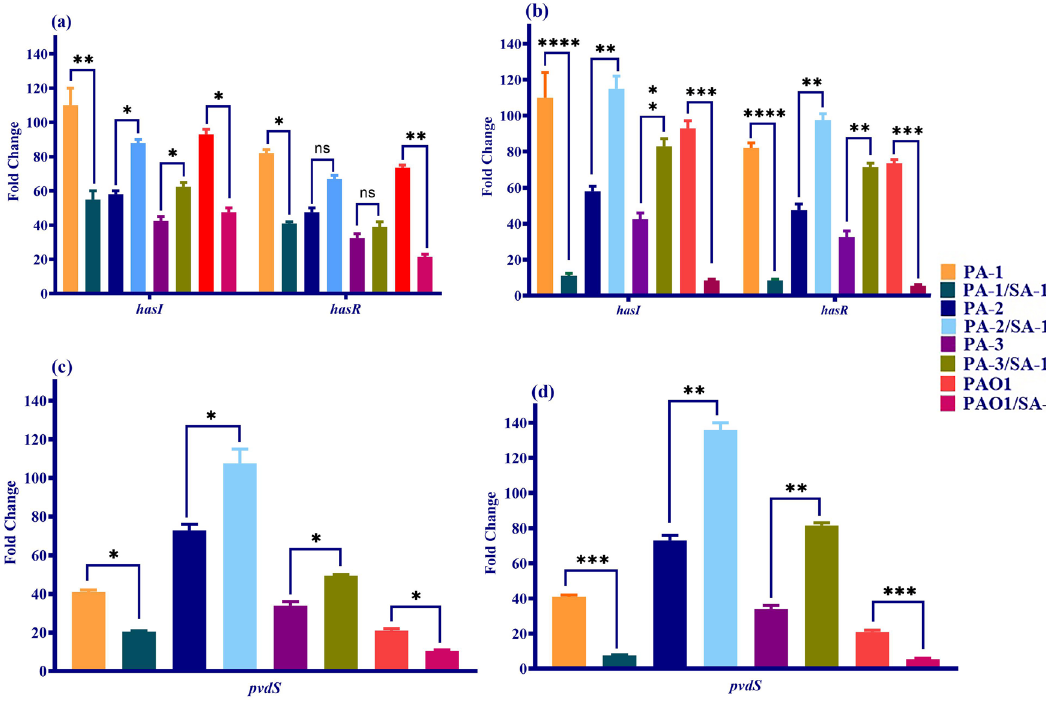
Figure 3. The expression level of ECF sigma factors of P. aeruginosa in different states of co-culture. ( a ) The expression level of hasI and hasR in the planktonic co-culture compared to the monoculture and control strain. ( b ) The expression level of hasI and hasR in the biofilm state of co-culture in comparison to the monoculture and control strain. ( c ) The pvdS changes in P. aeruginosa strains in the planktonic forms of the co- and monoculture. ( d ) The pvdS changes in P. aeruginosa strains in the biofilm forms of the co- and monoculture. Each data set was analyzed using the student’s t-test, and the Holm-Sidak method for multiple comparison. The data were presented as Mean + SEM. *p-value < 0.05; **p-value < 0.01; ***p-value < 0.001; ****p-value < 0.0001.